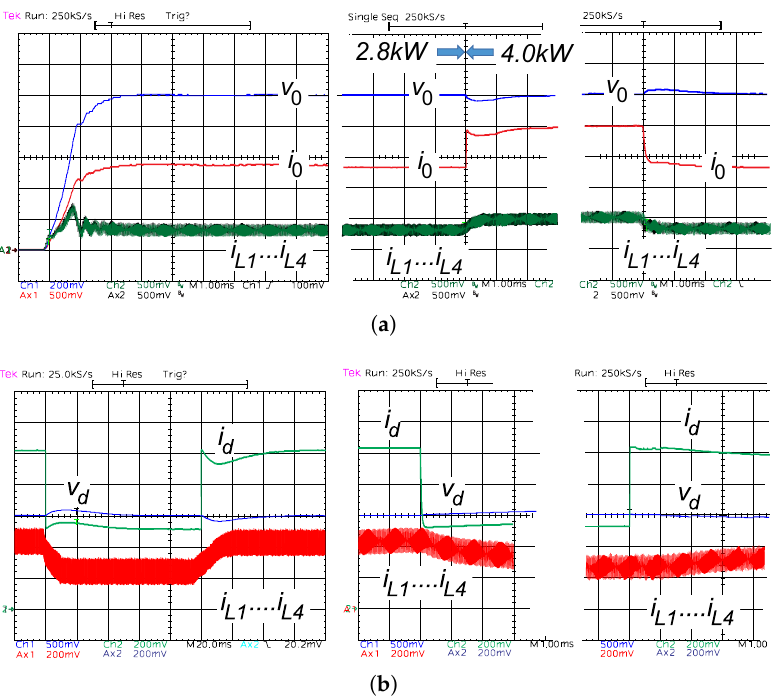
Figure 20. Experimental results, voltage control, when DR with CR and PI controller are applied; ( a ) buck converter operation; x -axis 1 ms/div, y -axis, V 0 40 V/div (blue curve); i 0 5 A/div (red curve) i L 1 to i L 4 5 A/div (green curve); ( b ) boost converter operation; x -axis 1 ms/div, y -axis, V d 100 V/div (blue curve); i d 2 A/div (green curve), i L 1 to i L 4 2 A/div (red curve).